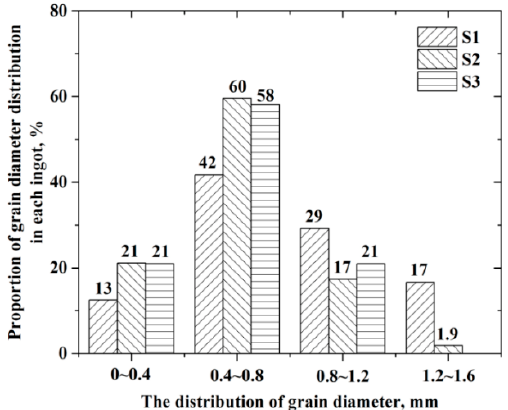
Figure 4. Grain diameter distribution of each sample.